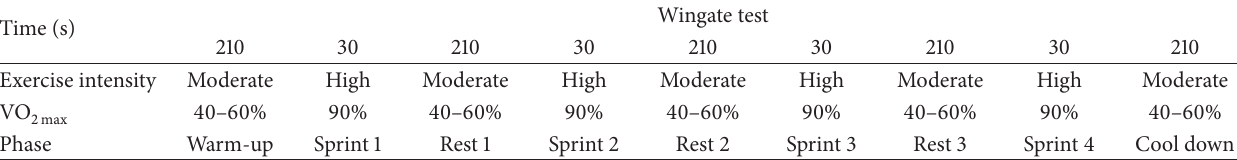
Table 1: A conventional Wingate test. This is a basic template. Researchers will change the times, intensity, and mode of exercise in order to fit their particular